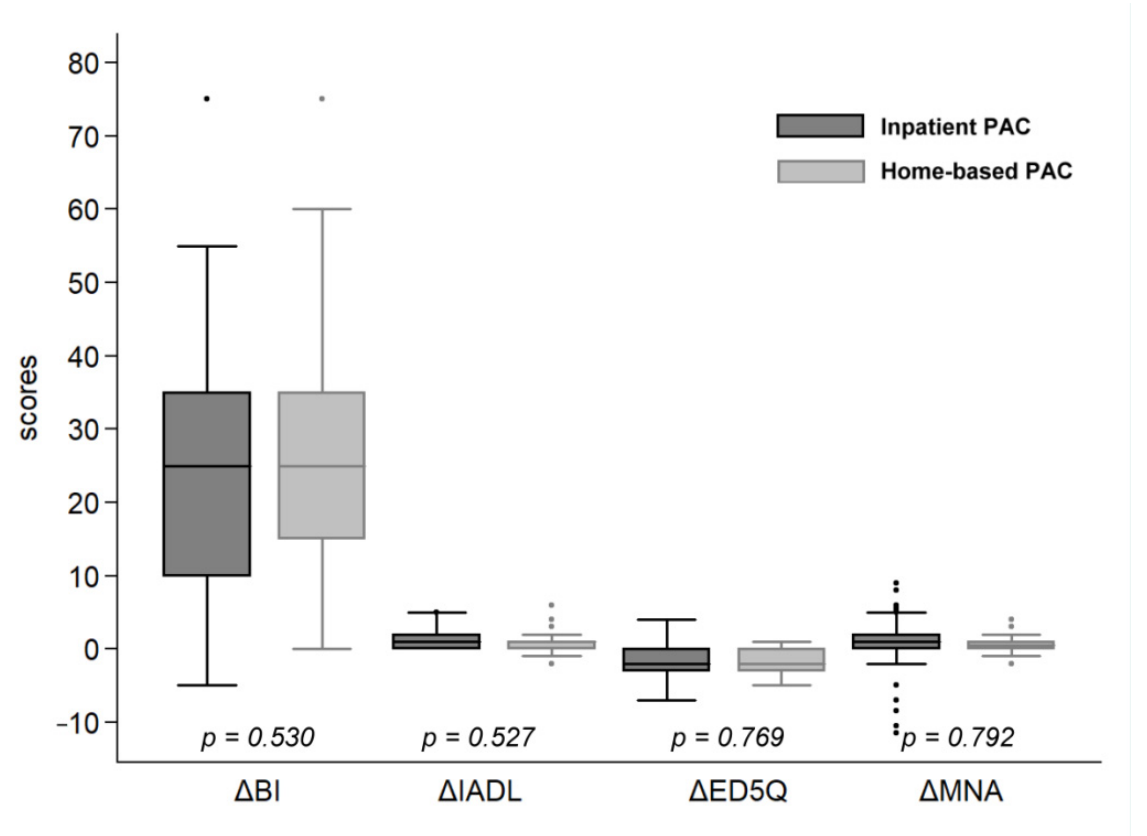
Figure 2. Functional improvements of daily activities, life quality and nutrition between inpatient and home-based PAC groups. · : outlier for inpatient PAC; : : outlier for home-based PAC.